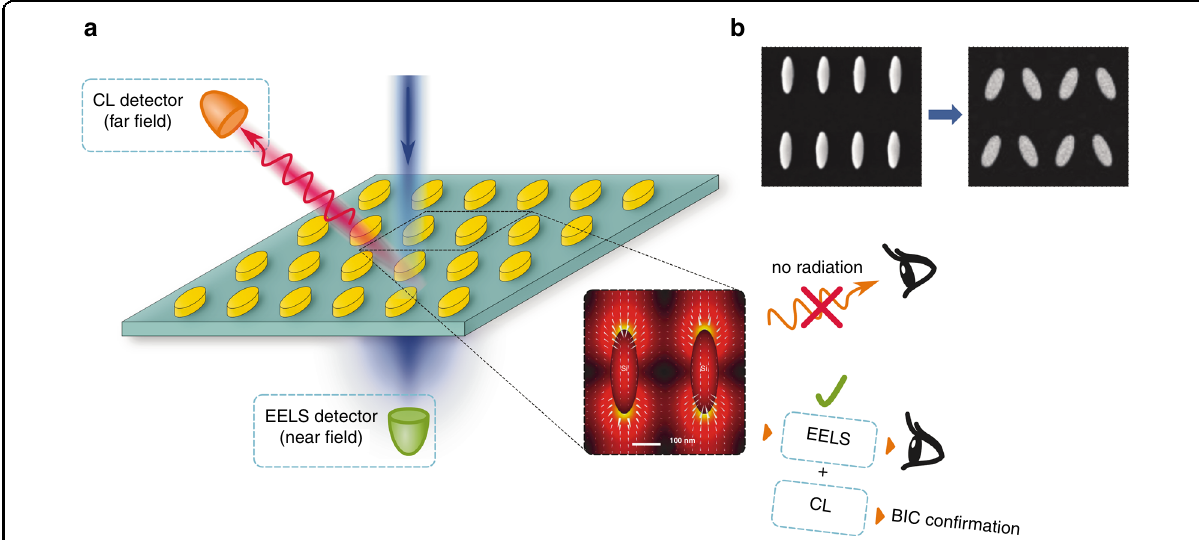
Fig. 1 Schematic for exciting and probing bound-states-in-the-continuum (BIC) modes. a Experimental STEM setup is used to focus a high- energy electron beam to probe a dielectric metasurface. Complementary measurements of the energy lost by electrons, and energy of emitted photons result in EELS and CL spectra respectively. b Transformation of BIC into